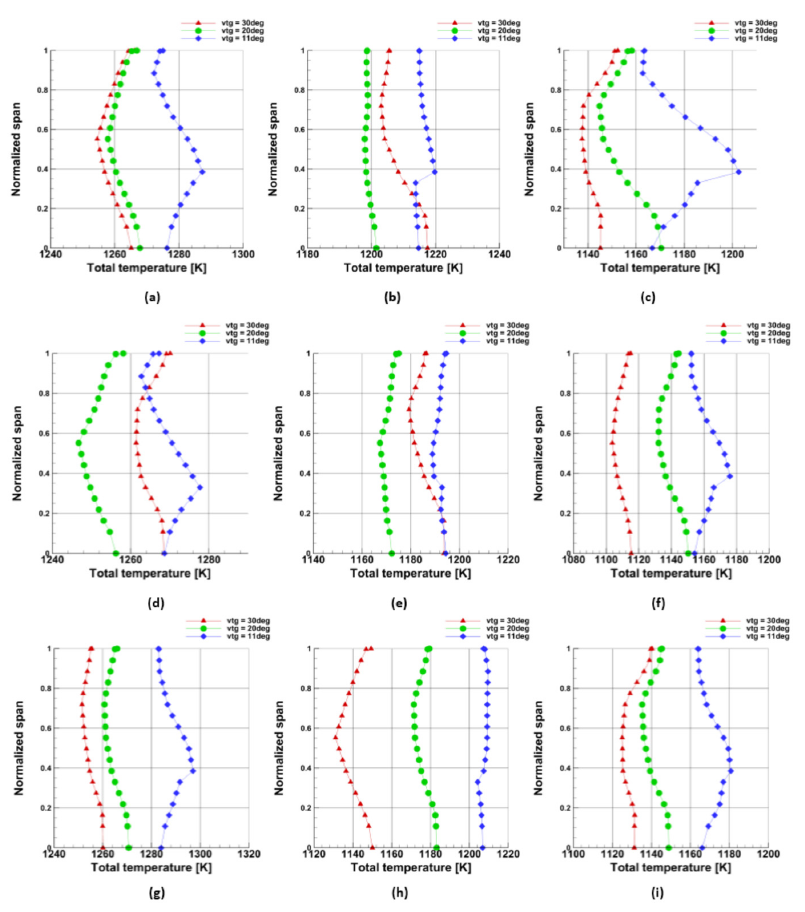
Figure 25. The plots of the total temperature measured behind the 1st stage nozzle vane against the blade height for: ( a – c ) 60,000 rpm point A, B, C respectively, ( d – f ) 50,000 rpm point A, B, C respectively, ( g – i ) 40,000 rpm point A, B, C respectively.